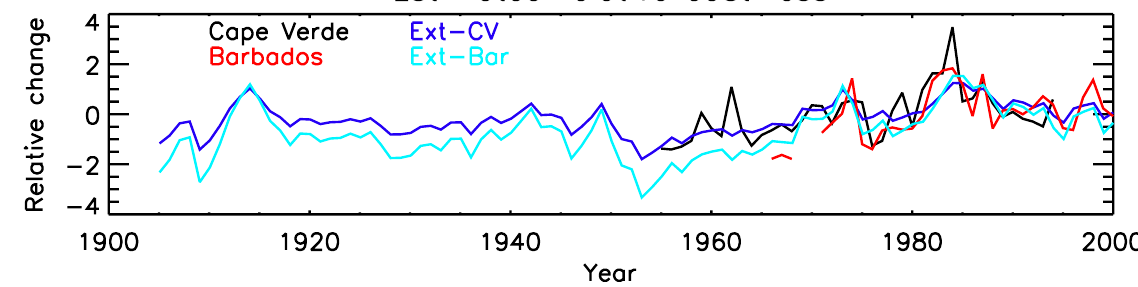
Fig. 1. Estimated relative dustiness for North Africa and North Atlantic. Cape Verde relative dustiness is shown in Black, while the extrapolated change in North African dustiness (using the Palmer Drought Severity Index-PDSI) is shown in dark blue. In situ concentration data from Barbados is shown in red (Prospero and Lamb, 2003), while extrapolated dustiness from the Barbados record and the PDSI is shown in light